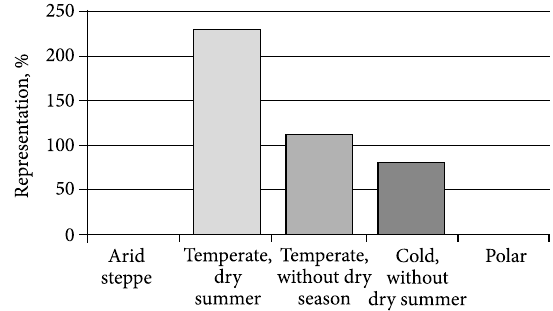
Fig. 4. Climatic representativeness of the COST action field sites vs. the EU28 agricultural area. 100% means that the proportion of field sites is the same as the proportion in the EU28 agricultural area. A representation value >100% indicates over-representation, and a value <100% indicates under- representation (Feb. 2015)